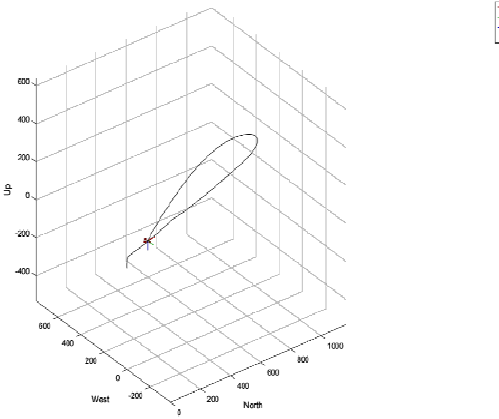
Figure 16. 3D view of Simulink flight path of the QAV To better imagine the flight path taken 2D by the Simulink, a plot concerning the position in the x, z and y, z axes are displayed in Figure 17,18 and 19, respectively. Figures 20, 21 and 22 presents the X, Y and Z distance response of the QAV, respectively. Figures 23, 24 and 25 illustrate the corresponding linear velocity function of QAV along X, Y and Z direction with time. Figures 26 ,27,28,29,30 and 31 display the angle around X-, Y- and Z-axes of the QAV, respectively. Figures 28, 29 and 30 depict the angular velocity of QAV around X-, Y- and Z- axes, respectively.